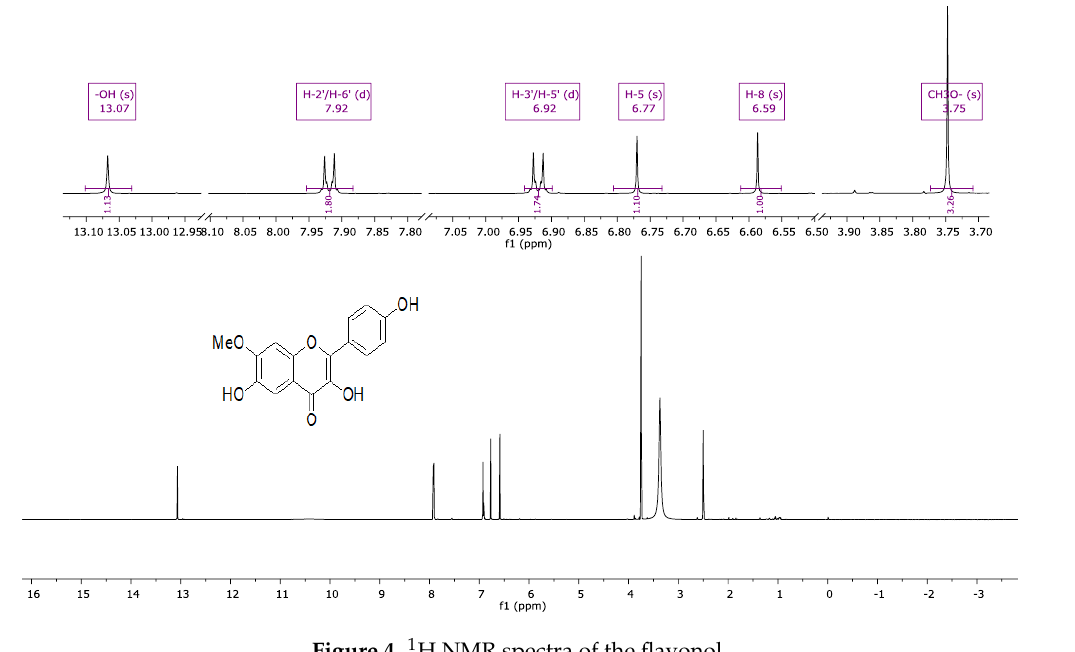
Figure 4. 1 H NMR spectra of the flavonol. Table 1. 1 H and 13 C NMR data for the flavonol.